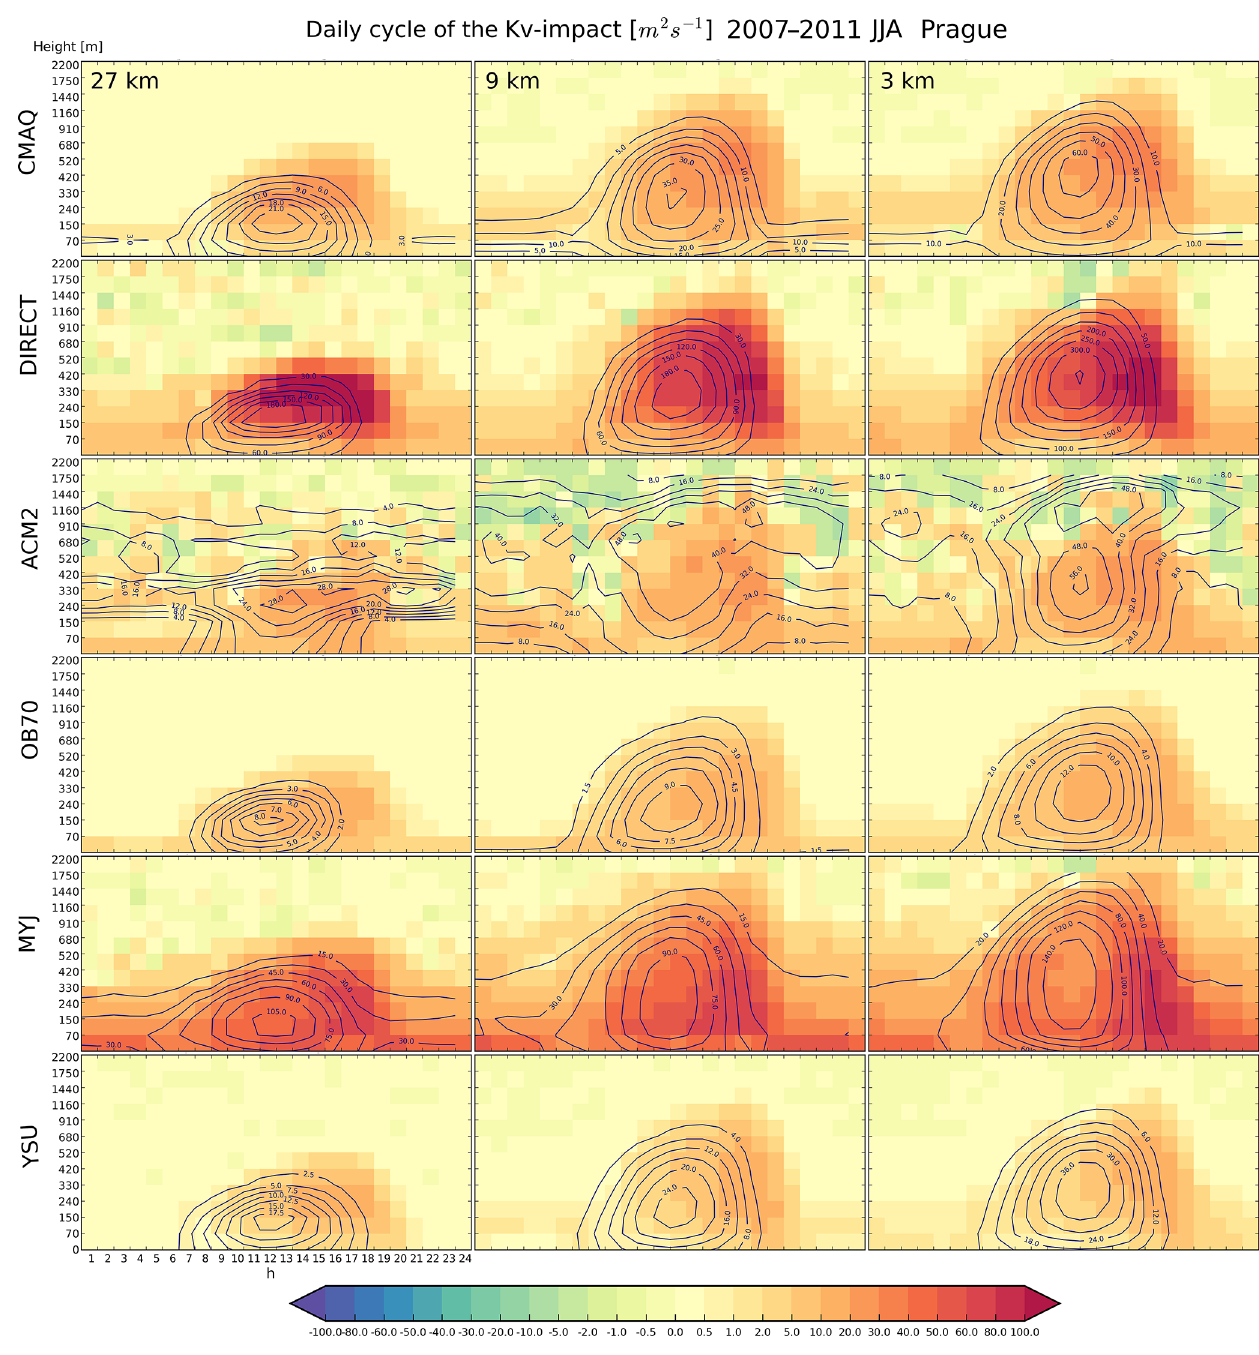
Figure 16. Impact of urban surfaces on the JJA diurnal cycle of the vertical eddy diffusion profile in m 2 s − 1 over Prague for the 27, 9 and 3km domains (columns from left to right). Individual rows represent different K v methods (CMAQ, DIRECT, ACM2, OB70, MYJ and YSU, from top to bottom). Contour lines denote the absolute K v values from the URBAN model